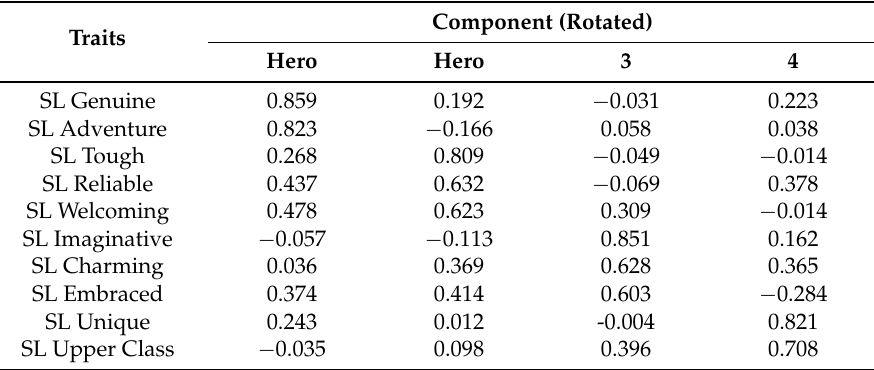
Table 5. SL Personality